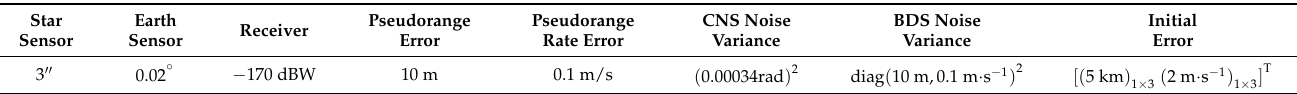
Table 8. Sensors and filter parameters